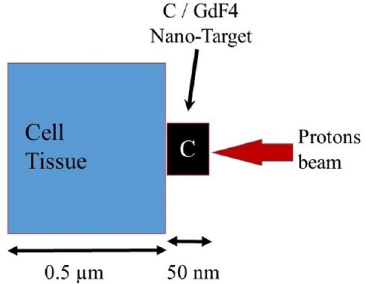
Figure 1. The geometry of the target in simulation. The cell tissue of 0.5 µm side cube, as a small segment of the tumor site, has been irradiated by protons having the energy spectra. The C or GdF4 nano-target, 50 nm side cube was placed between the incident protons and the cancerous tissue to increase the number of the secondary alpha